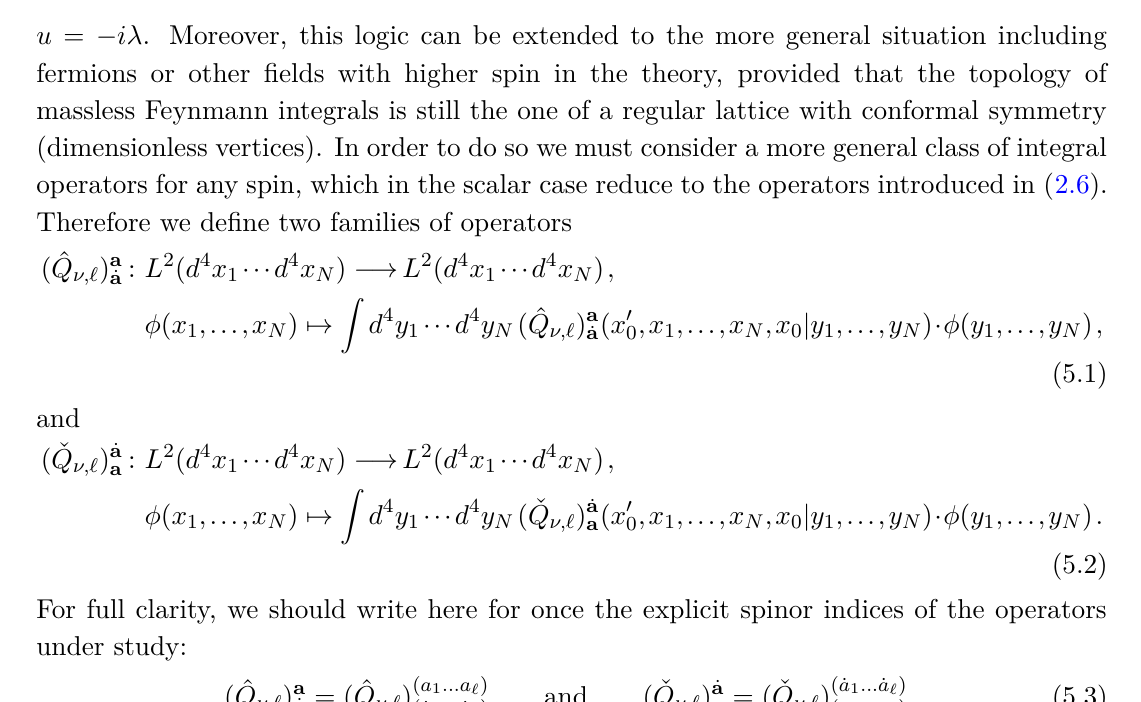
Figure 10 . Graphic representation of the integral kernels for the length N = 3 . The solid lines stand for scalar propagators (( x lines denotes the numerators [ x − y ] ‘ / (( x − y ) 2 ) 1 − iλ − iν while the dashed lines with a bar stand for [ x − y ] ‘ / (( x − y ) 2 ) 1 − iλ + iν . The arrows denote the order of the matrices σ , ¯ σ in the